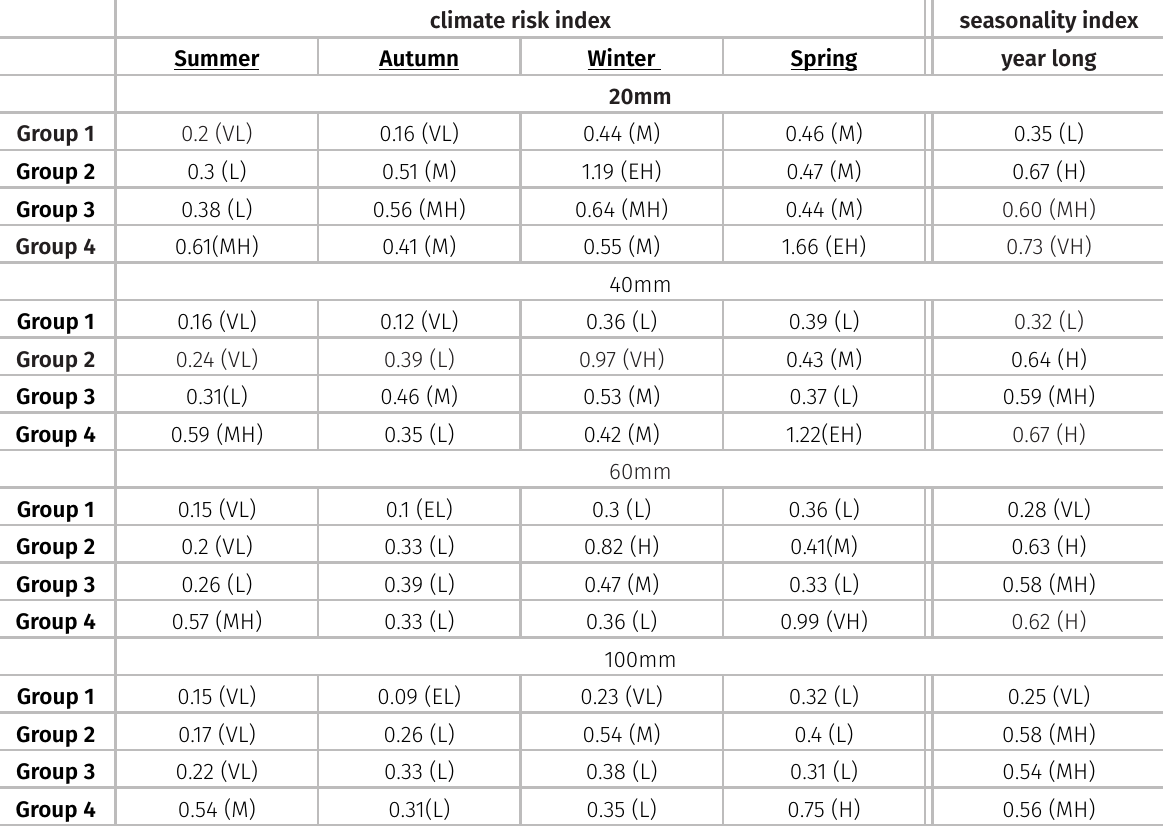
Table II. Indexes of climate risk and seasonality of Marandu palisade grass herbage accumulation rate associated with Groups of meteorological stations in Brazil, created by cluster